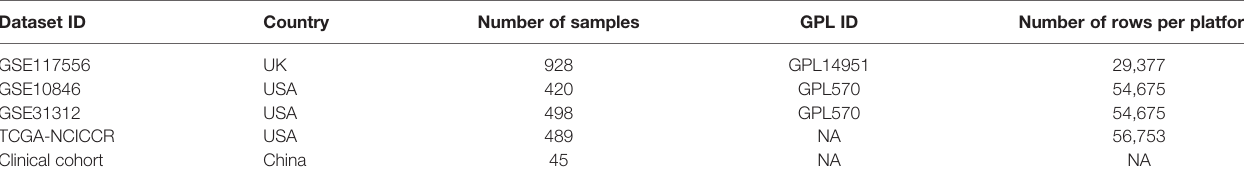
TABLE 1 | Characteristics of the included